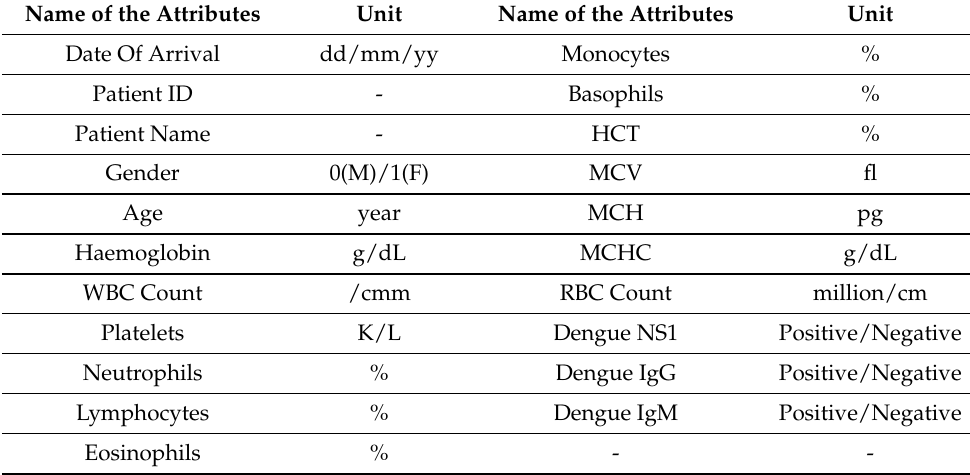
Table 3. Attributes of dataset collected from central hospital